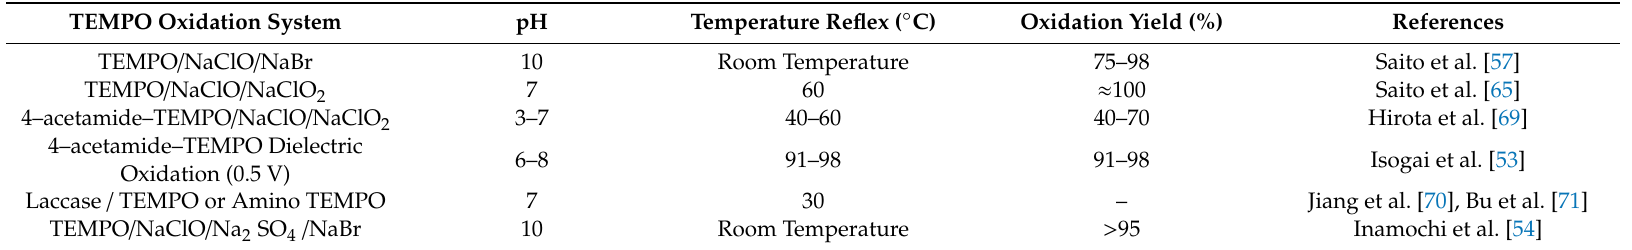
Table 2. Common 2,2,6,6–tetramethylpiperidine–1–oxyl radical (TEMPO) oxidation